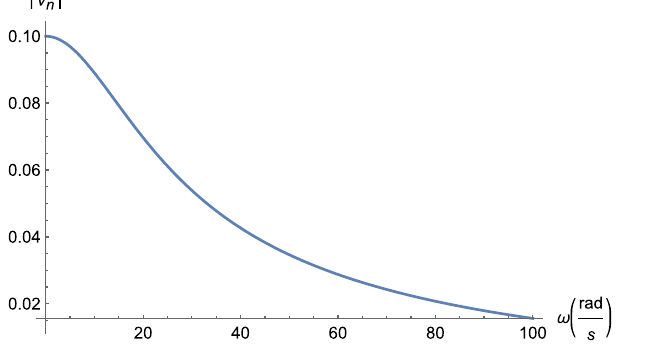
Figure 8. Magnitude of the frequency response for parameters that approximate an axon ( α = 10 − 6 , R = 10 12 � , C = 10 − 8 F , and | ν 0 | = 100 mV ).